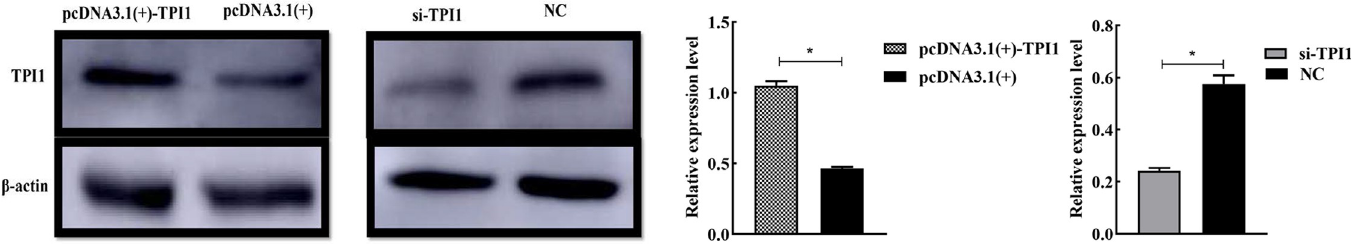
PLOS ONE | https://doi.org/10.1371/journal.pone.0270364 September 22,